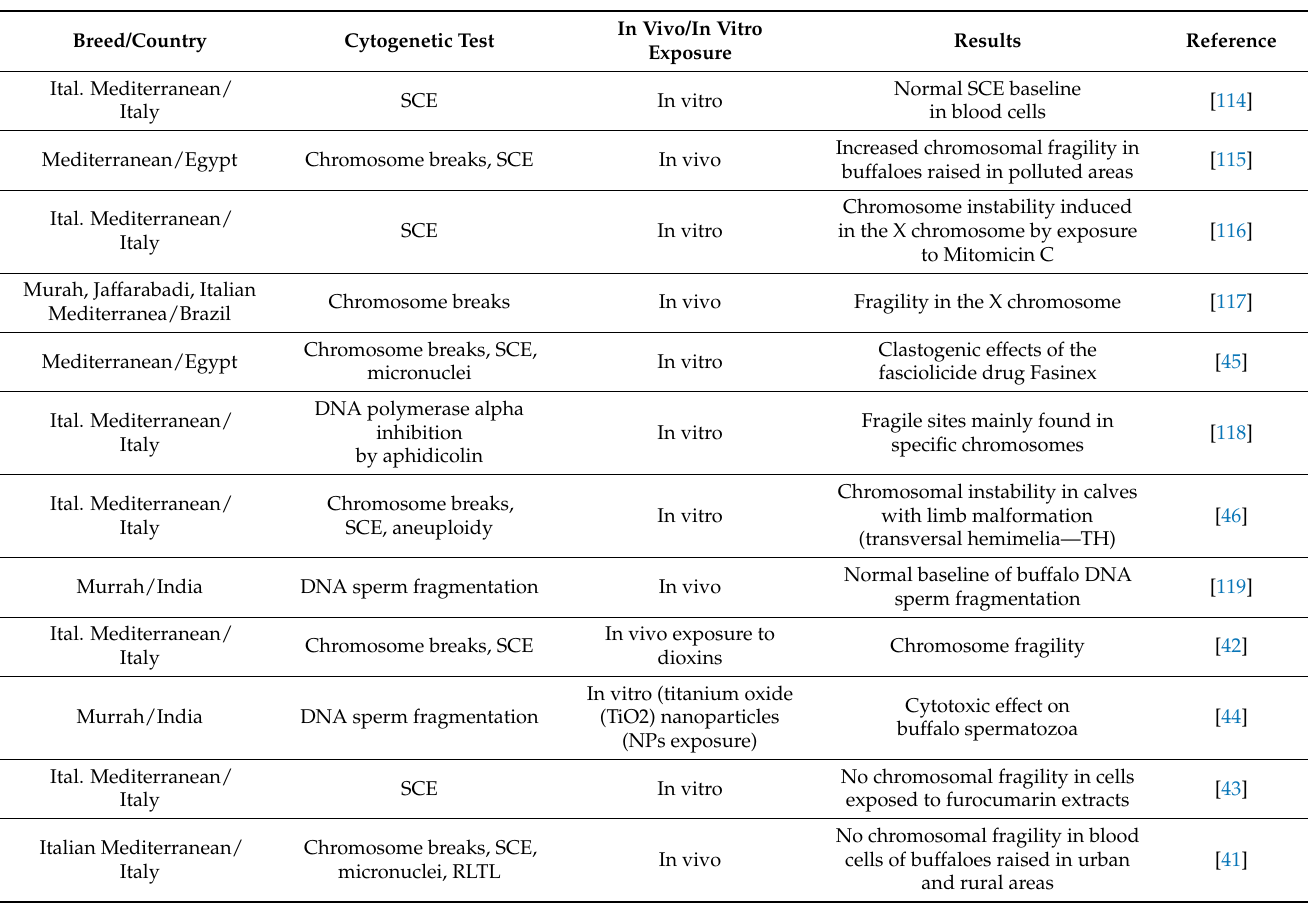
Table 4. Cytogenetic test applied to river buffalo cells or sperm after in vivo (natural exposure) or in vitro exposure to potential mutagens; results and